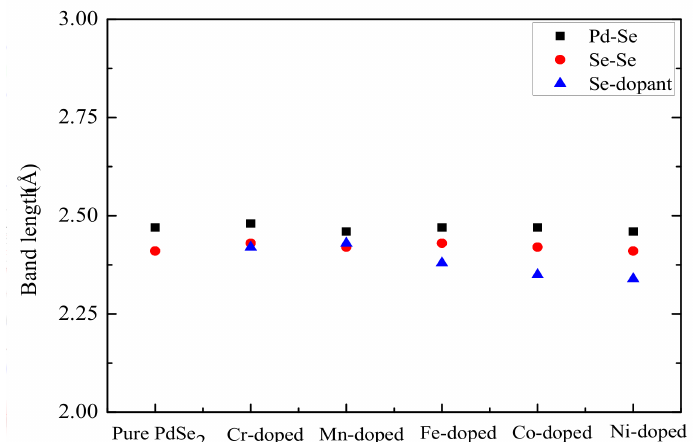
Figure 2. Bond length for different PdSe 2 systems.